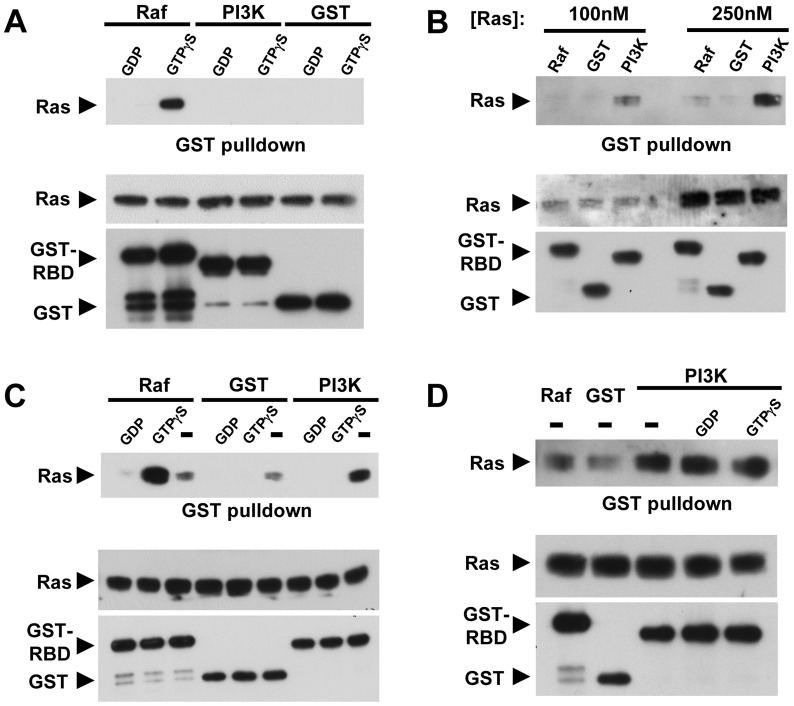
Binding of PI3KC2β-RBD to Ras.(A) Nucleotide loaded Ras does not directly interact with the RBD of PI3KC2β. Ras-GDP or Ras-GTPγS were incubated with GST-Raf-RBD, GST-PI3KC2β-RBD or GST alone as a negative control. Bound proteins were then analyzed by Western blot with a Ras antibody. The RBD of Raf specifically bound Ras-GTPγS. Neither GST-PI3KC2β-RBD nor GST alone interacted with Ras-GDP or Ras-GTPγS. Top panel, Ras bound to GST proteins. Bottom panels, input amounts of proteins. (B) Nucleotide-free Ras was generated in vitro as described and then tested for binding to the various GST proteins as in (A). GST-PI3KC2β-RBD directly binds nucleotide-free Ras while little association was seen with the GST-Raf-RBD or GST alone. Panels are same as in A. (C) Repeat of (B) except nucleotide (1 mM) was present during the binding reaction. Panels are same as in (A). (D) Addition of nucleotide (1 mM) does not disrupt pre-bound PI3KC2β-RBD- nucleotide-free Ras. GST-PI3KC2β-RBD was first bound to nucleotide-free Ras. Following binding, the complex was incubated with 1 mM GDP or GTPγS at RT for 30 min and then washed with buffer. Bound proteins were then analyzed as in (A).